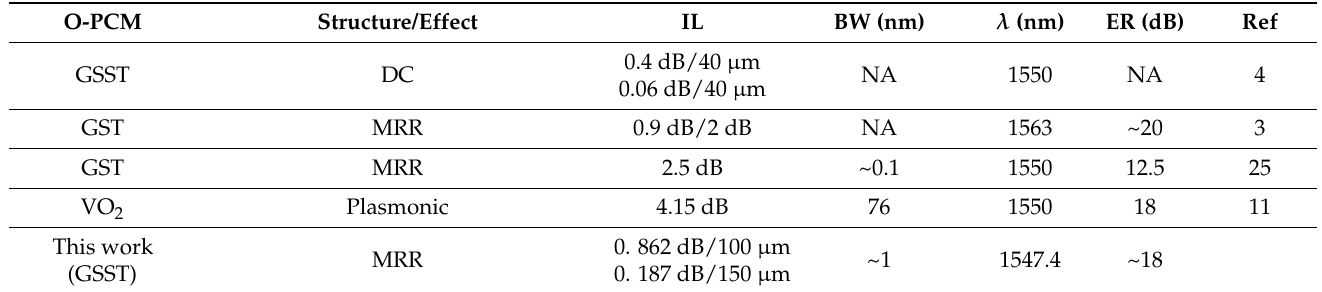
Table 1. Switching performance comparison with reported